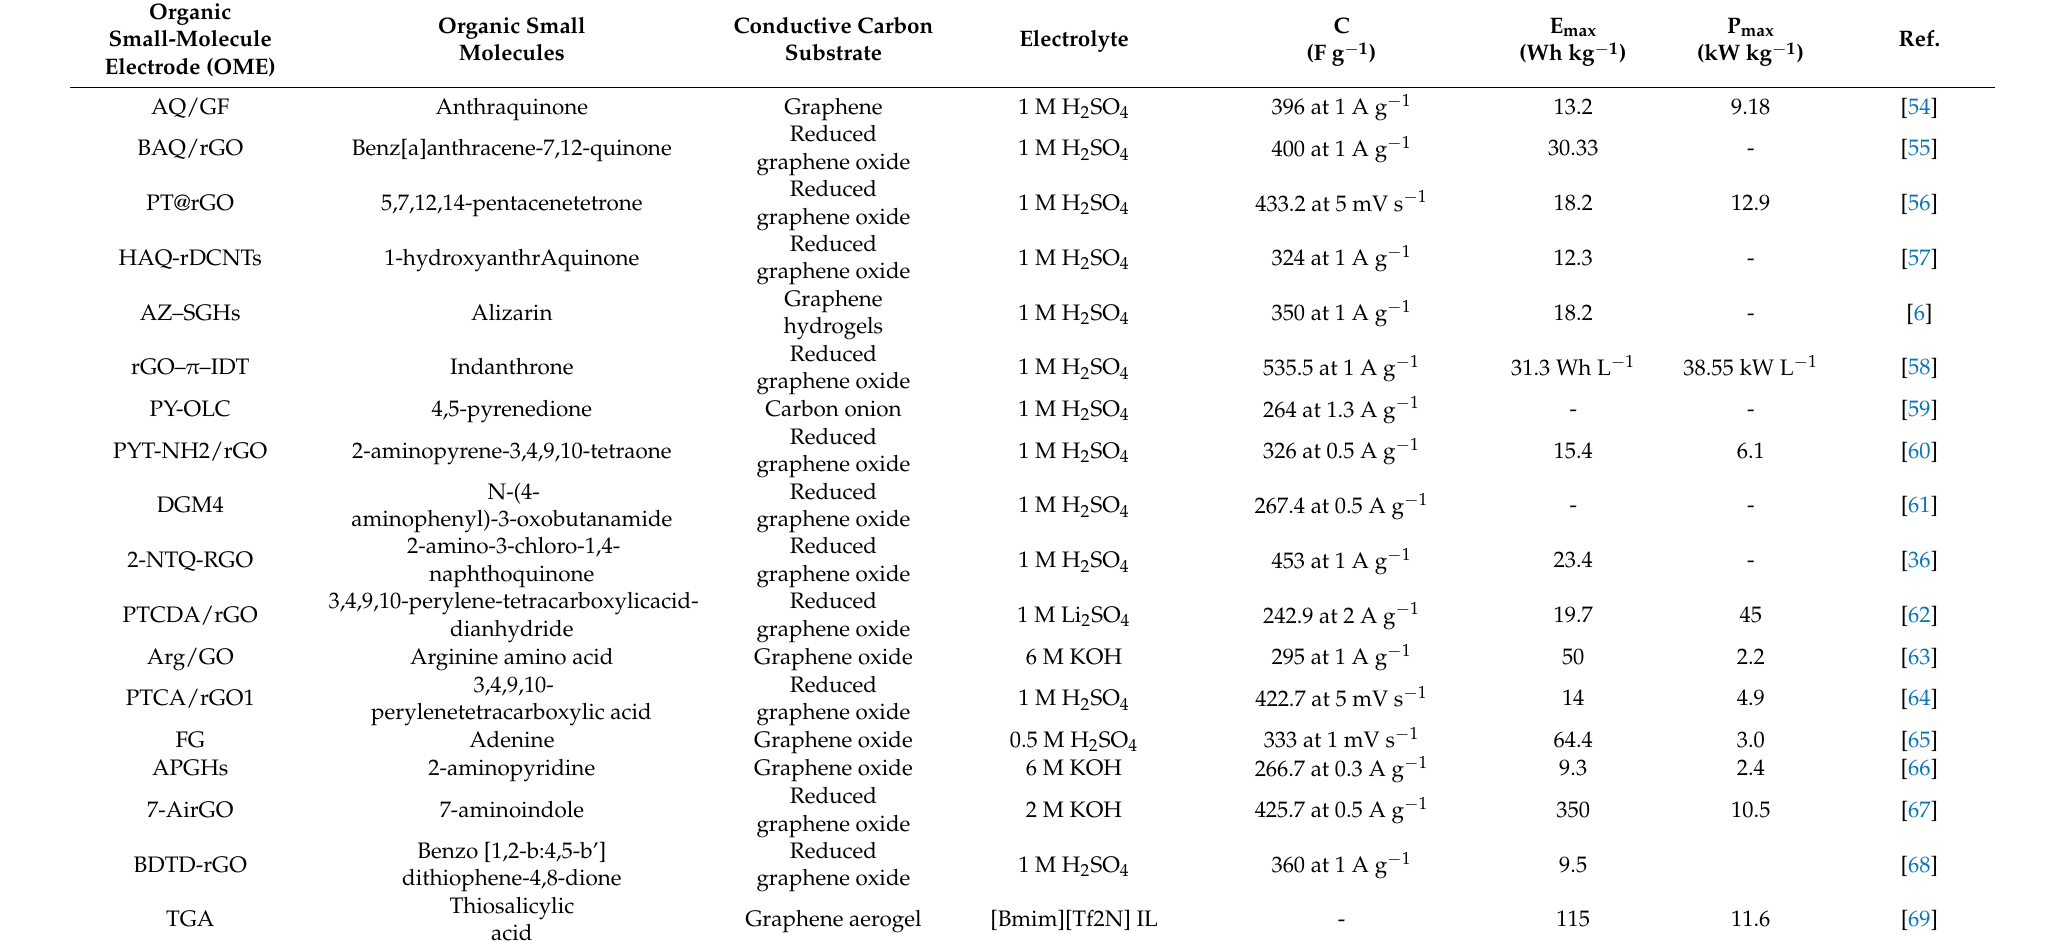
Table 1. The electrochemical performance of organic small-molecule electrodes in different